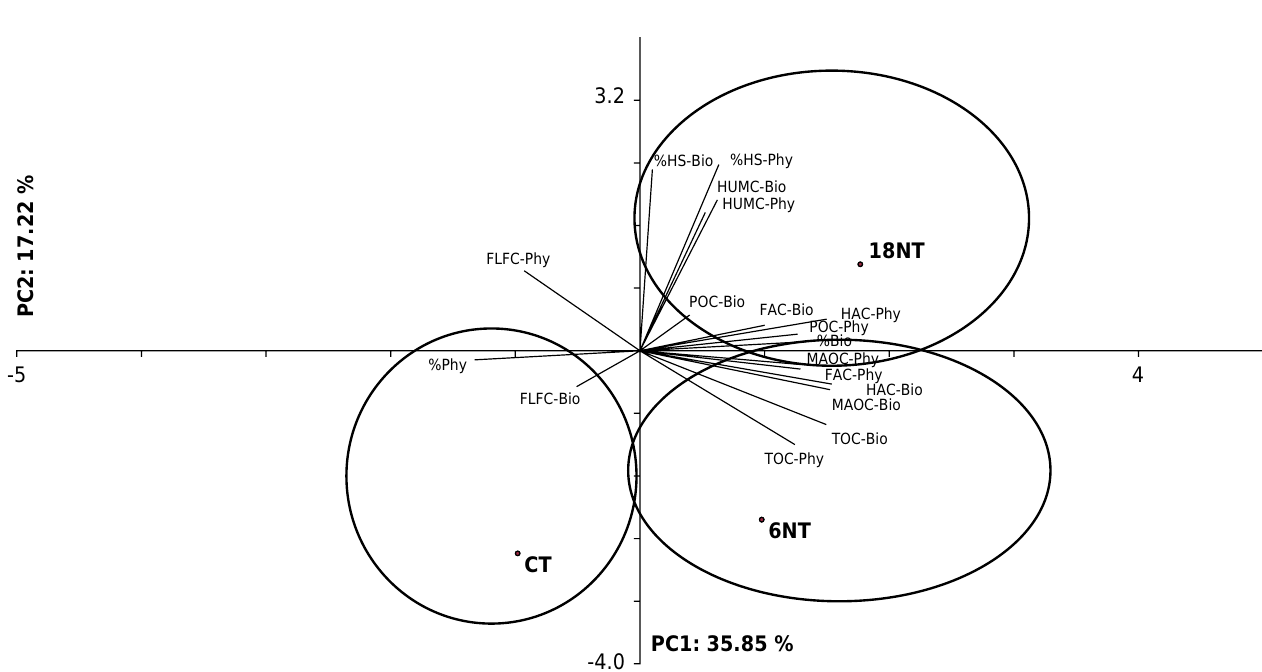
Figure 7. Principal component analysis of total organic carbon and chemical and physical fractions of soil organic matter in physicogenic (Phy) and biogenic (Bio) aggregates from 0.05-0.10 m soil layer under different management systems in the Cerrado region of Uberaba, Minas Gerais, Brazil. CT: 20-year conventional tillage; 6NT: 6-year no-till; 18NT: 18-year no-till; TOC: total organic carbon; FAC: fulvic acid carbon; HAC: humic acid carbon; HUMC: humin carbon; %HS: percentage of humic substances; POC: particulate organic carbon; MAOC: mineral-associated organic carbon; FLFC: free light fraction carbon; %Phy: percentage of physicogenic aggregates; %Bio: percentage of biogenic